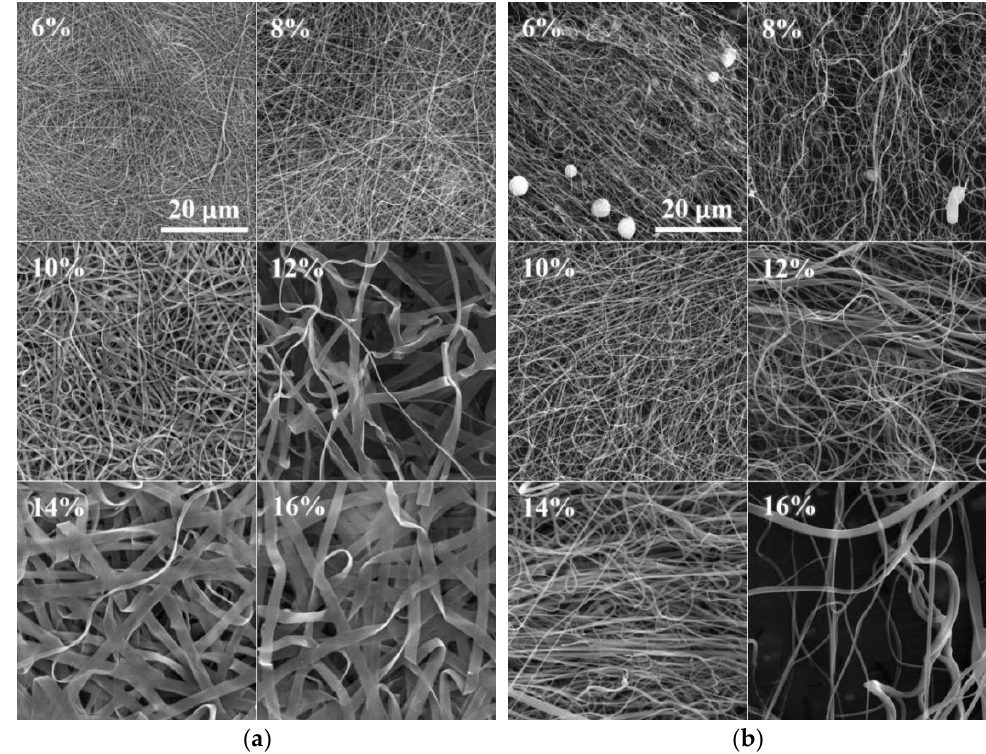
Figure 3. SEM images of the DC ( a ) and AC ( b ) electrospun PA4|6 nanofibers (the scale from the first image applies to all the images). Increasing numbers of ribbons were observed in the DC electrospun samples, whereas this phenomenon was not observed for the AC electrospun samples.